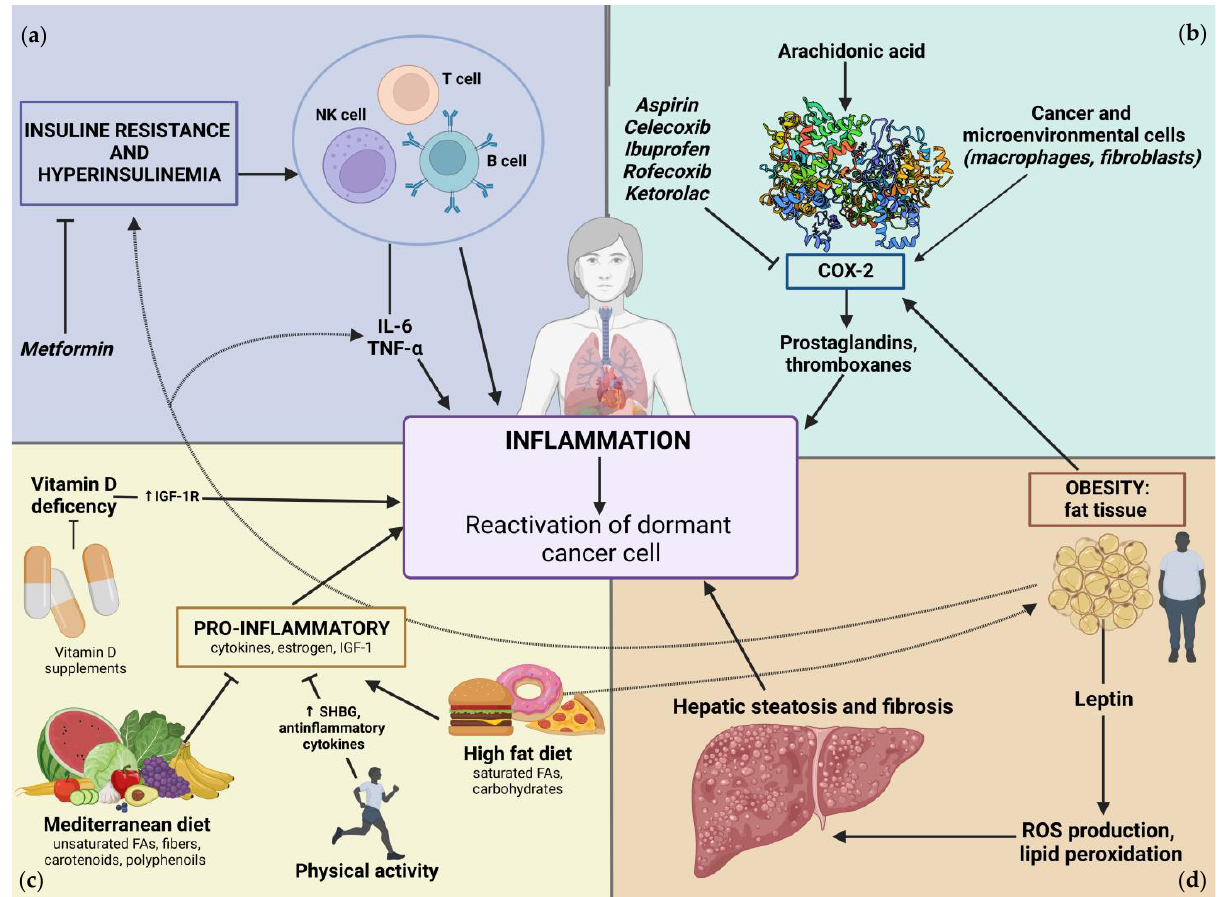
Figure 2. Host-related factors that influence the reactivation of DCCs through the modulation of systemic inflammation. ( a ) Insulin-resistance and hyperinsulinemia: elevated levels of insulin could affect the systemic inflammation, either directly, by activating immune cells, or indirectly, through the induction of proinflammatory cytokines (i.e., interleukin-6 (IL-6) and tumor necrosis factor α (TNF α ) also secreted by adipose tissue) that, in turn, boost local inflammation. ( b ) Prostaglandin-mediated inflammation: cancerous and normal cells from neoplastic tissue could express cyclo-oxigenase-2 (COX-2) enzyme. It converts arachidonic acid into prostaglandins, thus inducing local inflammatory response and acting on vascular compartment. ( c ) Lifestyle: particular types of lifestyles could affect levels of pro- and anti-inflammatory cytokines. Mediterranean diet and physical activity have the potential to reduce the levels of systemic inflammation. Conversely, a high-fat/high-sugar diet directly stimulates the release of factors that sustain inflammation (as insulin-like growth factor-1 (IGF-1)) and increases the risk of obesity. Vitamin D deficiency correlates with increased IGF-1 receptor (IGF-1R) activity, further promoting inflammation. ( d ) Obesity: adipose tissue could actively secrete inflammatory cytokines and sustain systemic inflammation through leptin production, which foster radical oxygen species (ROS) formation and lipid peroxidation. These processes increase the risk of steatohepatitis, which exacerbates systemic inflammatory response. SHBG: sexual hormone binding globulin, T cell: T-lymphocyte, B-cell: B-lymphocyte, NK cell: natural killer